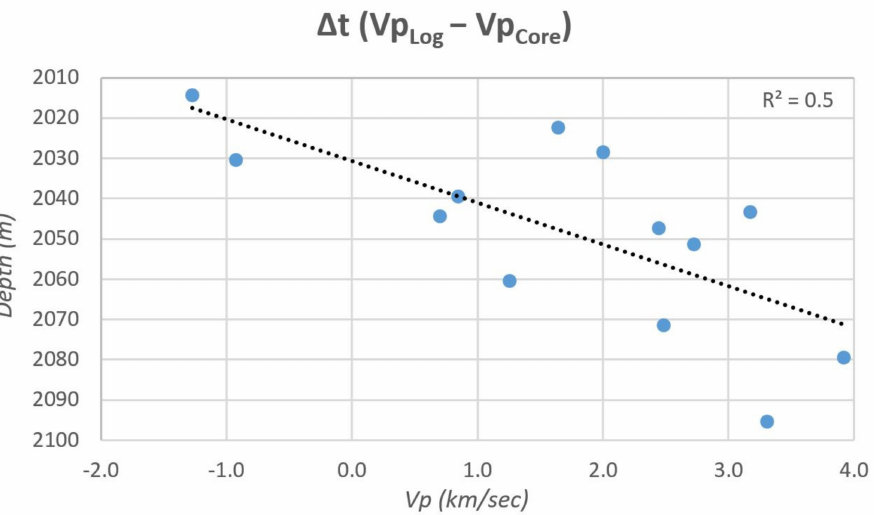
Figure 13. Correlation of the difference between the Vp Log values (Vp log ) and Vp measured values in 13 samples (Vp core ) of the Eureka 1 well. The R 2 values are rounded to the first decimal